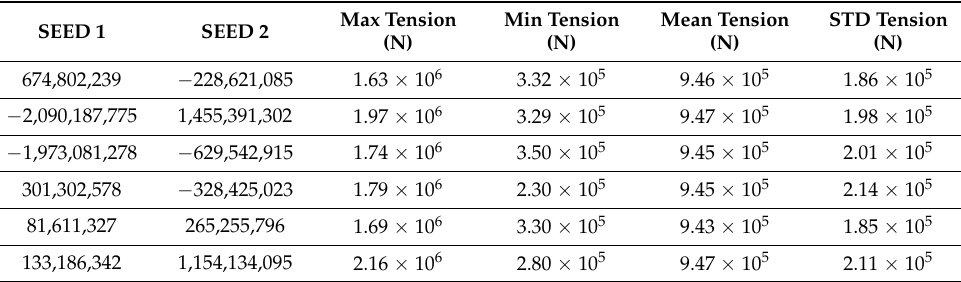
Table 11. DLC 6.1 Results for VolturnUS 6-MW Moored with the Optimized Candidate